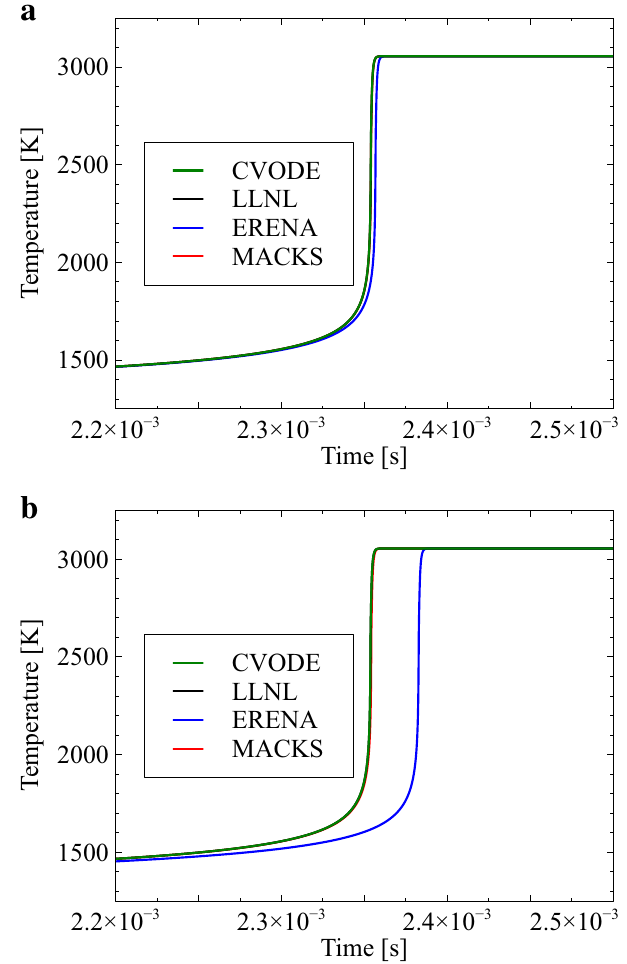
Figure 5. Time histories of temperature with CVODE, LLNL, ERENA, and MACKS for a CH 4 /air mixture with h = 1 × 10 − 8 and 1 × 10 − 7 s , p 0 = 1.0MPa , and T 0 = 1300K